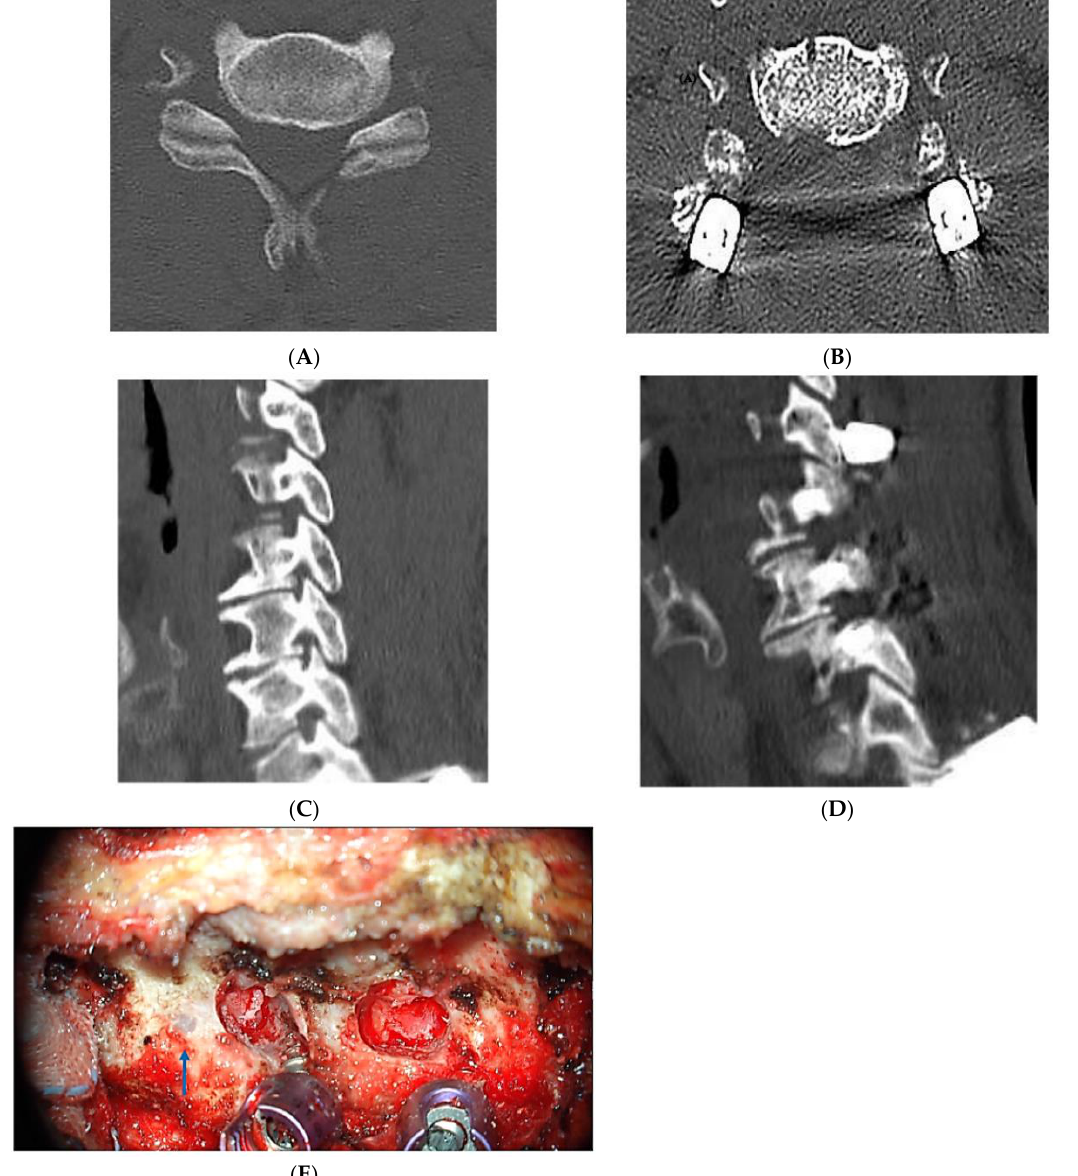
Figure 4. Posterior foraminotomy in the posterior pedicle group. ( A ) Preoperative CT axial image showing foraminal stenosis. ( B ) Postoperative axial image showing foraminotomy and laminectomy with pedicle screws. ( C ) Preoperative CT sagittal image showing foraminal stenosis. ( D ) Postoperative CT sagittal image showing extensive foraminotomy from the cephalic to caudal pedicles. ( E ) Intraoperative photographs showing foramen decompression and pedicle screws before and after expansive laminectomy. It is our surgical preference to perform foraminotomy before laminectomy. Arrow indicates a pre-drilled entry point for lateral mass screws. This figure is present to demonstrate the contrast regarding the amount of foraminotomy. When pedicle screws are used, expansive foraminotomy can be carried out from pedicle to pedicle. In contrast, when LMS is used, such expansive foraminotomy cannot be performed to preserve sufficient bone stock to secure the stability of lateral mass screw fixation, which has been proven by biomechanical study [30]. LMS, lateral mass screws; CT, computed tomography.